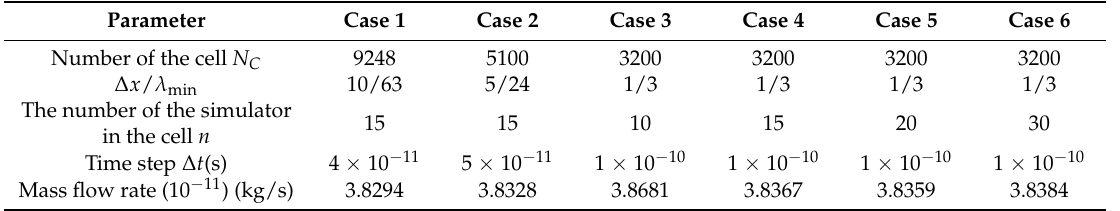
Table 1. The mass flow rate for different cell sizes and the numbers of the simulator in the cell, at the